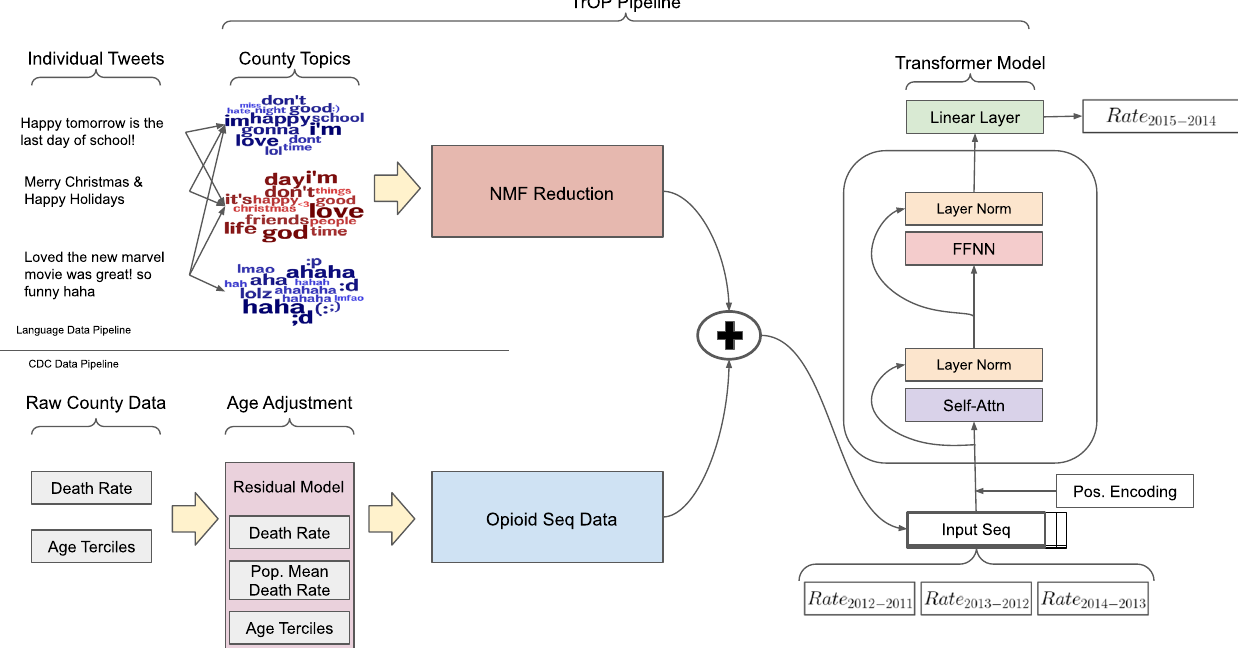
Fig. 7 Data pipeline and architecture of the T R OP system. Flow of T R OP from data collection to prediction. We pull from 2 data sources, the CDC for opioid and age-related information and Twitter for language data for each county. We then build the feature representations for each data source and concatenate them for each year (indicated by ’ + ’ ). Finally, the yearly sequence data is passed to our transformer predictive model to forecast the rate of change in opioid death rate per